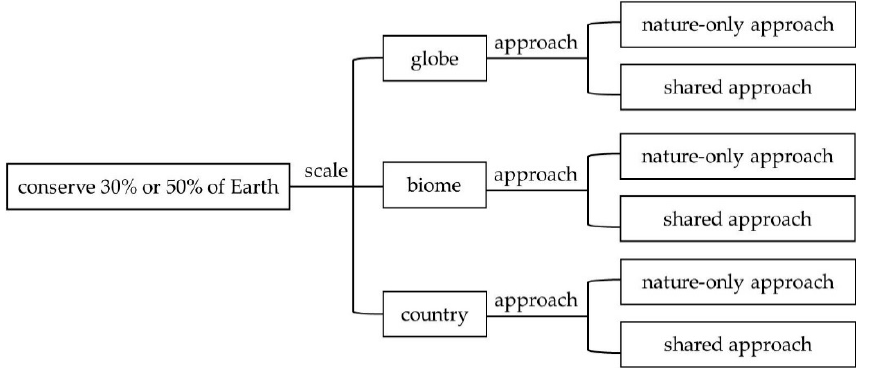
Figure 5. The six combinations of three spatial scales and two approaches in identifying conservation areas according to ranking of pixels and land classes.